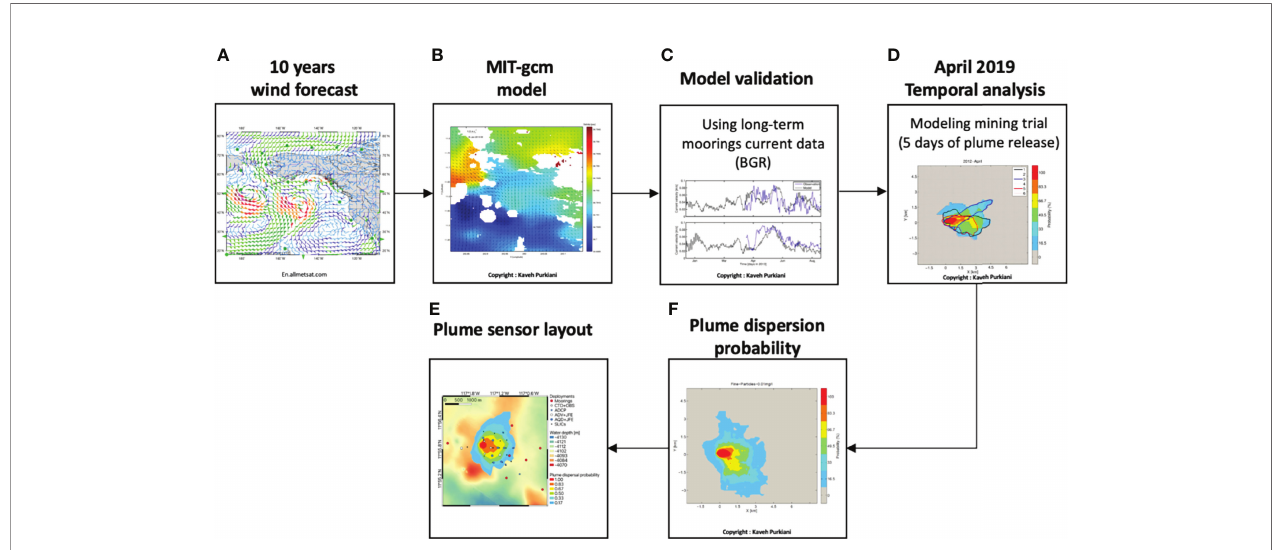
FIGURE 3 | Development of plume dispersion probability map, used as a basis for determining the actual sensor layout for plume monitoring. (A) Gathering 10-year wind forecast. (B) Forcing data in the MIT-gcm hydrodynamic model. (C) Validation of the model using long-term mooring current data as obtained by BGR. (D) Temporal analysis of plume dispersion based on integration of a sediment transport module. (E) Plume dispersion probability map. (F) Plume sensor layout